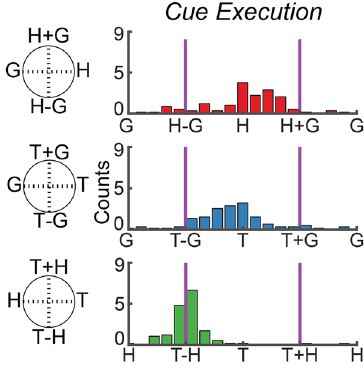
Fig. 3 Population summary of single unit gradient analysis. Histograms show gradient resultant orientations for the population of tuned